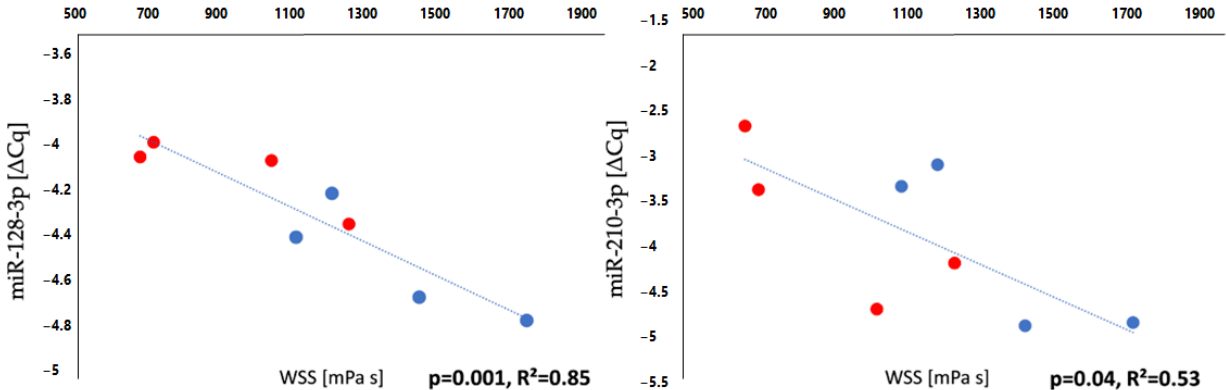
Figure 6. Correlation between WSS and miRNA. Relationship between WSS and miRNA expression in n = 4 patients with anterior-right dilation. Red = average of posterior segments; blue = average of anterior segments. Both graphs show less miRNA expression and higher WSS in the dilated seg- ments.